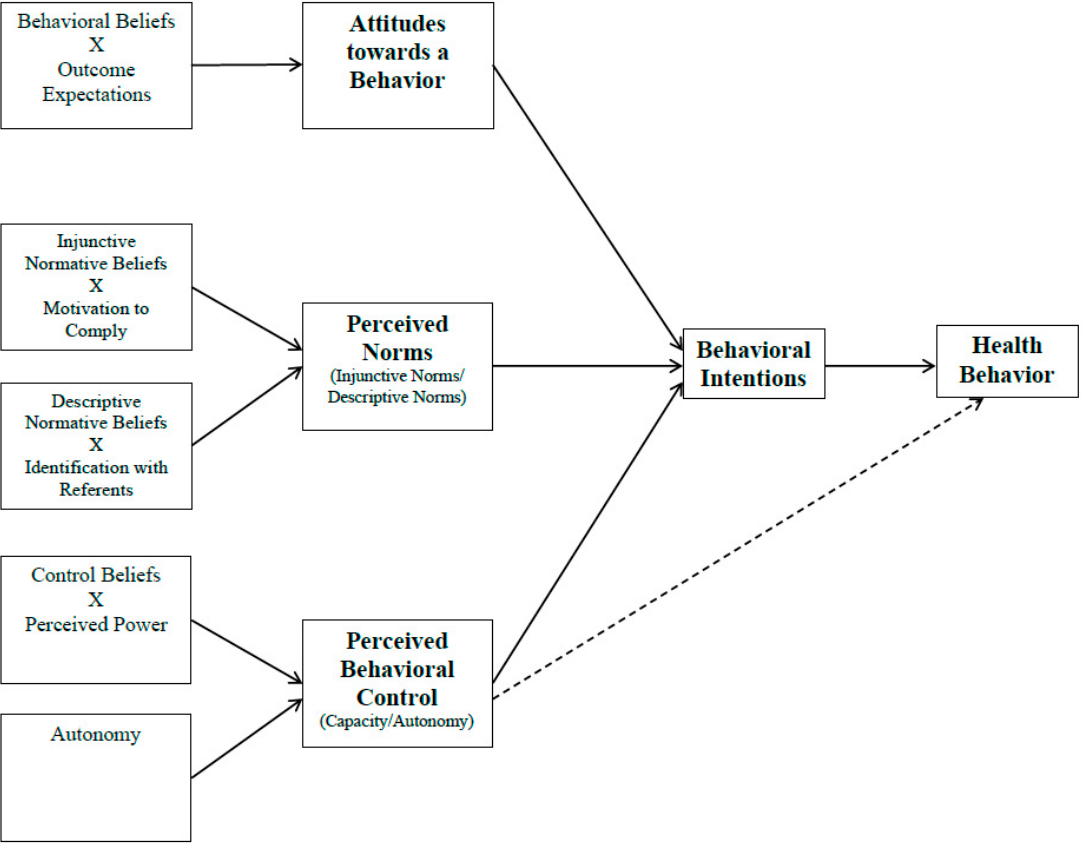
Figure 1. The Integrated Behavioral Model.